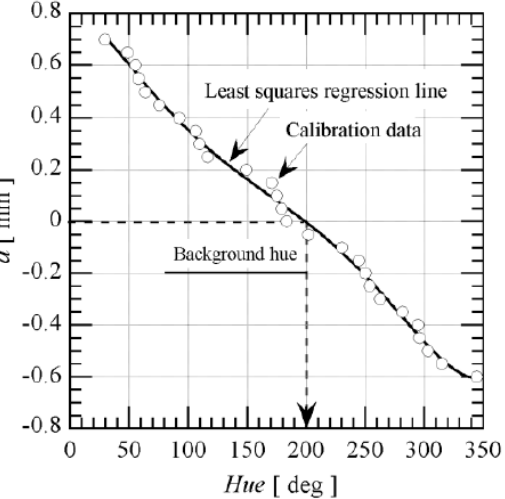
Figure 30. Calibration curve of the rainbow Schlieren system. Reprinted with permission from Ref. [45] (2018).